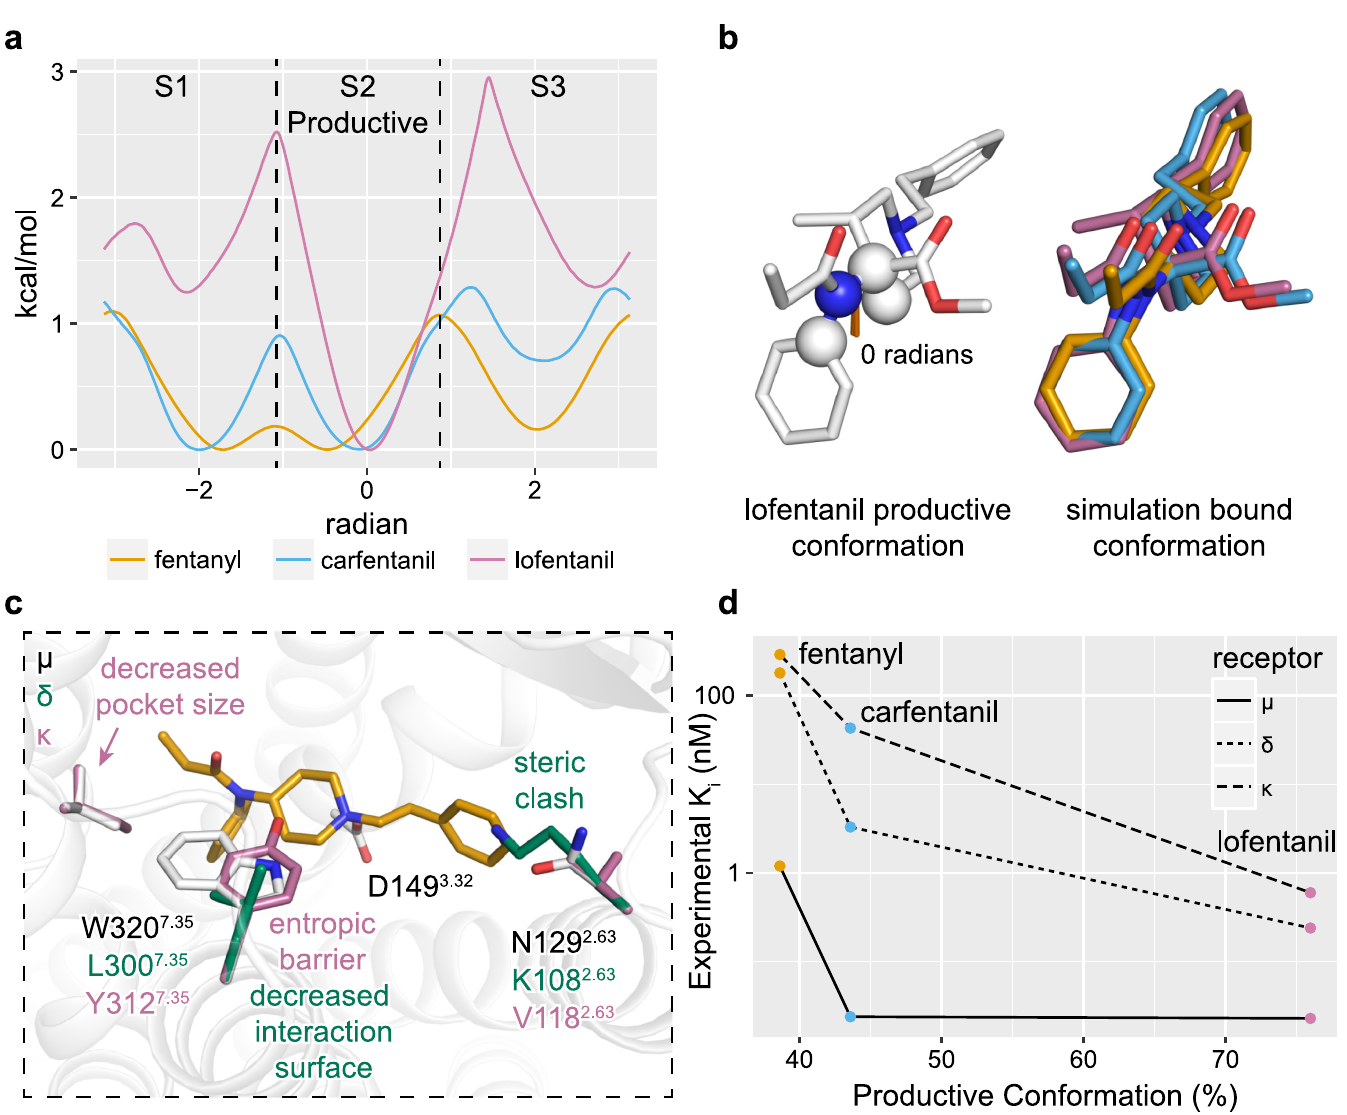
Fig 3. Piperidine rigidity influences both affinity and selectivity. a, N-aniline-piperidine connecting dihedral free energy landscapes. S2 dihedral occupancy for fentanyl, carfentanil, and lofentanil was calculated to be 38.5%, 43.4%, and 75.9% respectfully. b, Superposition of lofentanil’s optimal S2 dihedral conformation with low-energy conformations identified in mABP ligand binding simulations. c, Comparison of μ OR, δ OR, κ OR orthosteric site amino acid compositions and selectivity structural analysis. d, Correlation between S2 dihedral propensity with in-vitro potencies taken from ref [30].